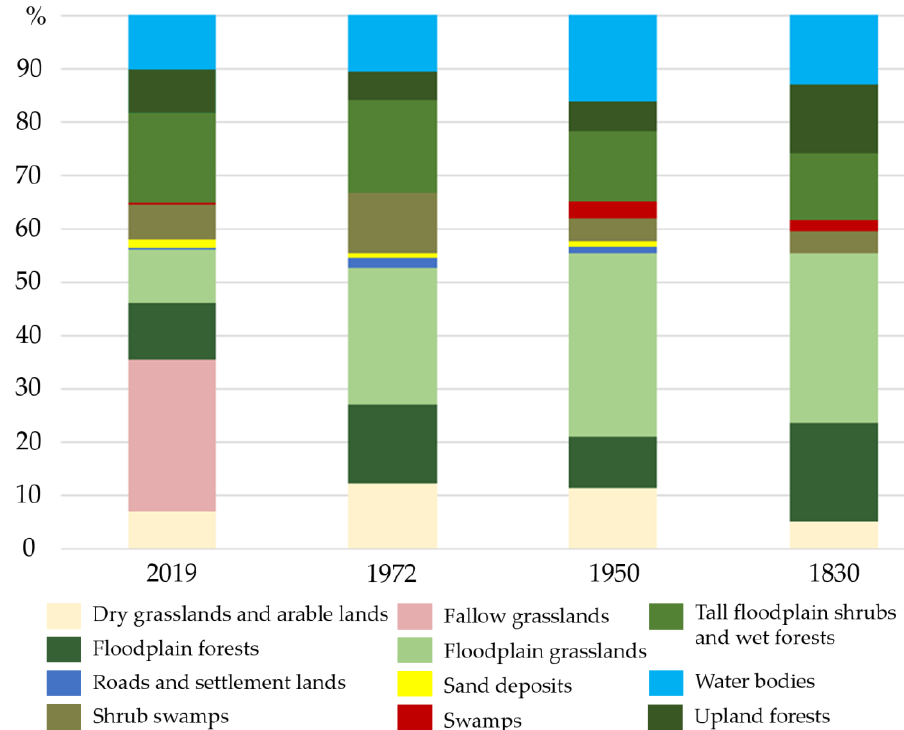
Figure 3. Dynamics of landscape areas.